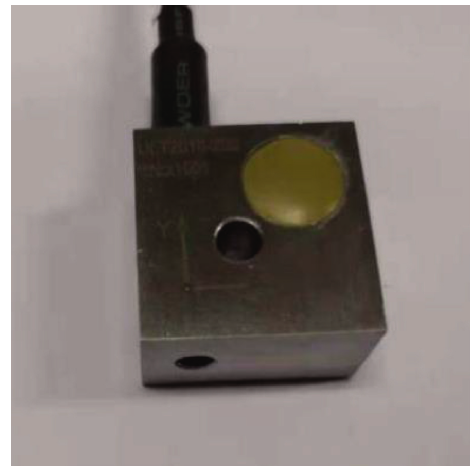
Figure 6: ULT2010-500 triaxial acceleration sensor.